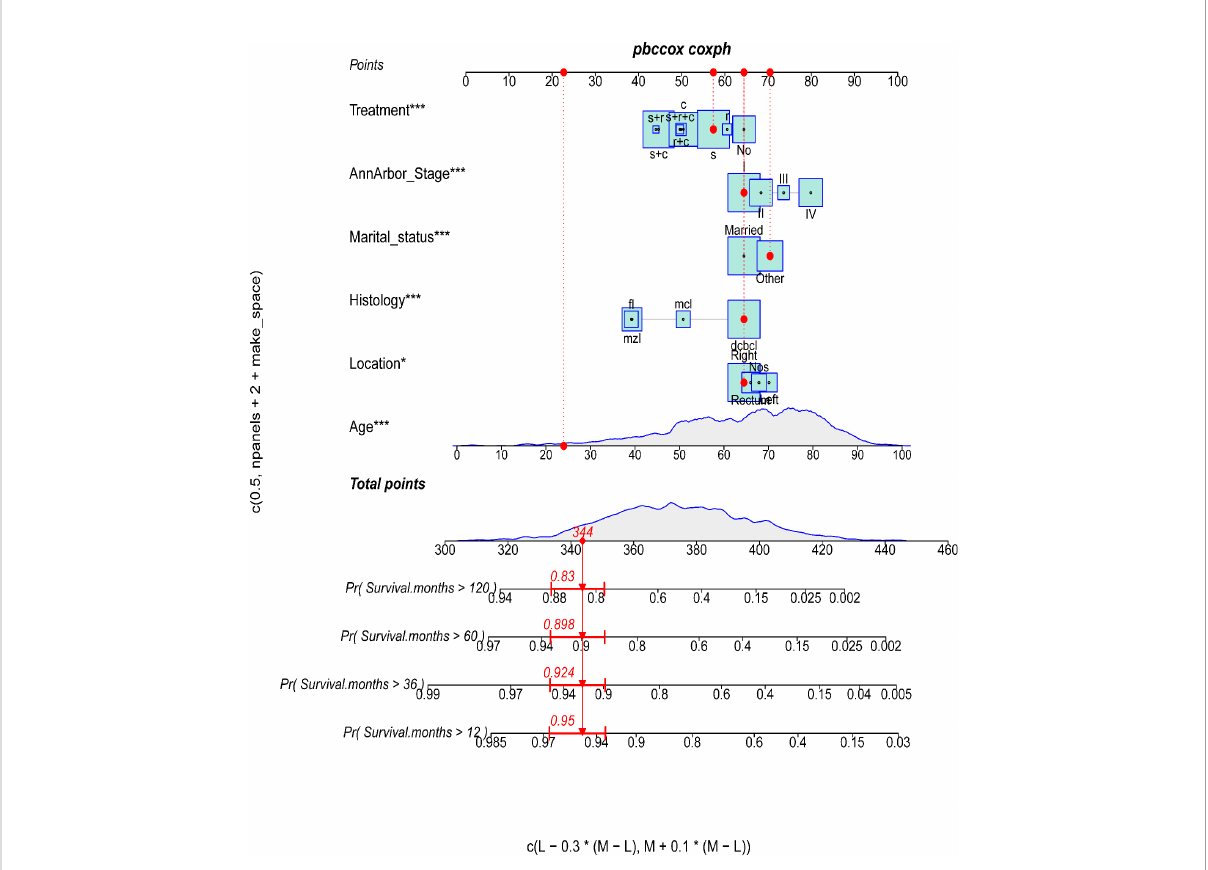
FIGURE 2 The predictive nomogram for OS of PCL patients. The symbols “ * ” indicate that the p-value for this variable is less than 0.05. More symbols “ * ” indicate a smaller